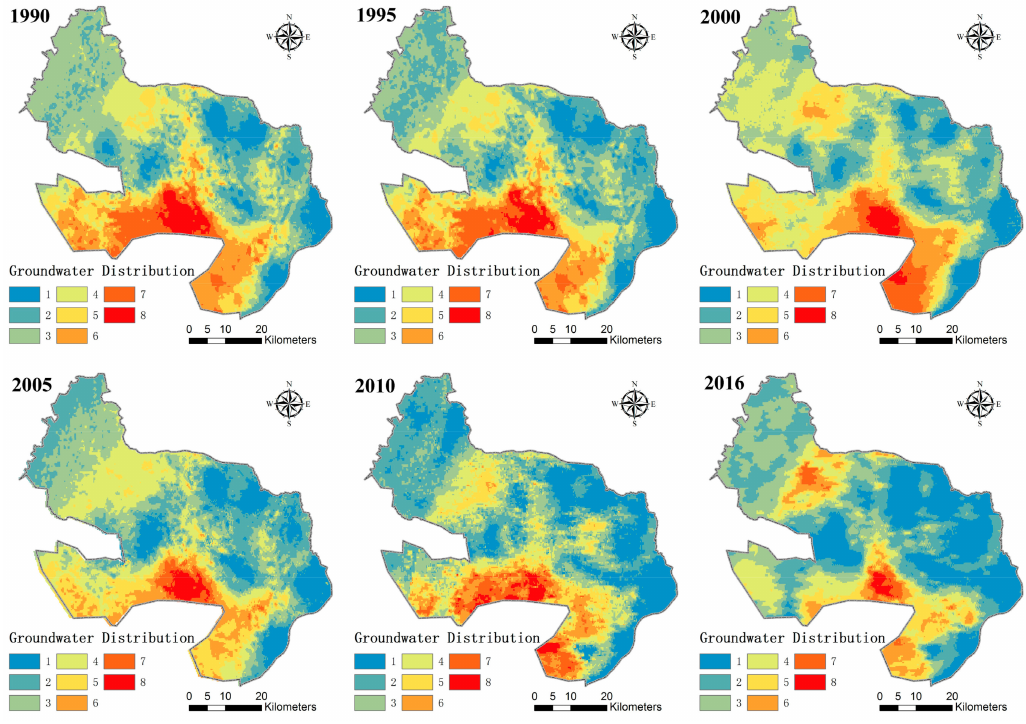
Figure 11. The spatial classification data of Water Table (WT) depth. Table 3. The maximum and minimum values of groundwater depth